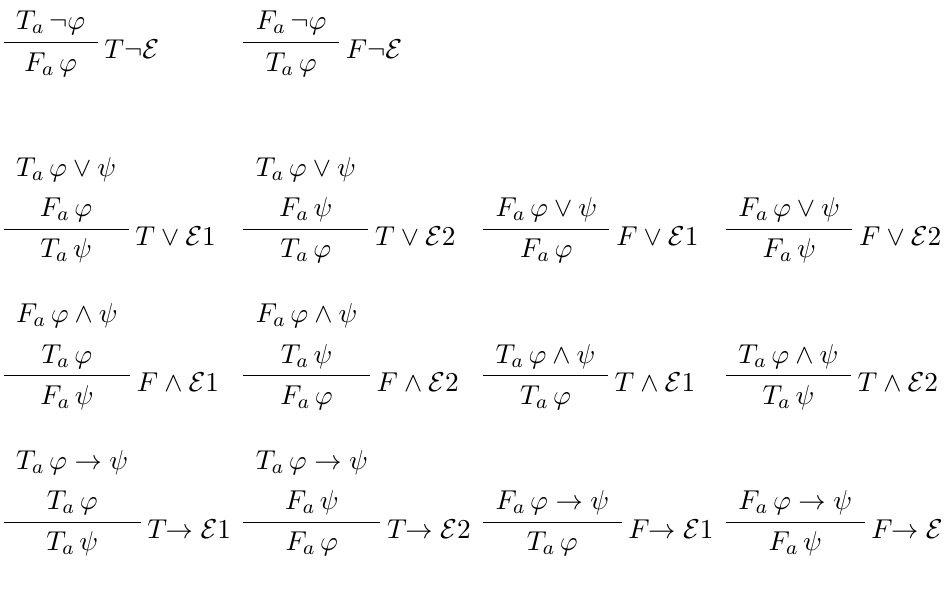
Table 3. Necessary conditions (elimination rules) for the four standard Boolean